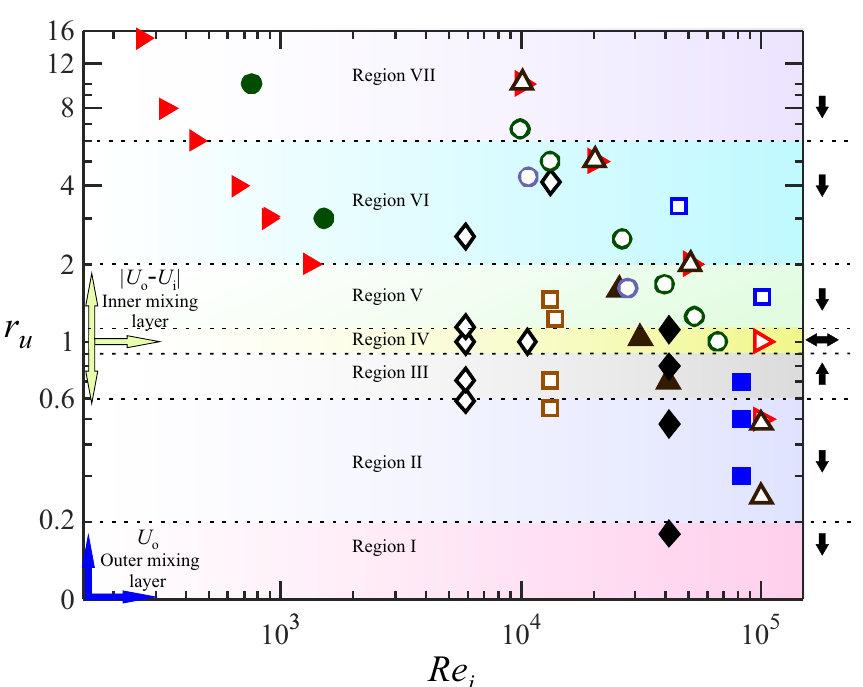
Figure 4. Overview of the literature publications summarized in Tables 1 and 2 plotted here as r u versus Re i . Horizontal dashed lines separate between different identified regions (see Table 2). Yellow and blue arrows point in the direction of increasing magnitudes of the velocity jumps, and U o , in the inner and outer mixing layers, respectively. Black arrows point in the direction of increasing inner potential core length. ( ) [41,42], ( ) [23], ( ) [23], ( ) [15], ( ) [25], ( ) [26], ( ) [16], ( ) [43], ( ) [14], ( ) [28], ( ) [29], ( ) [44].